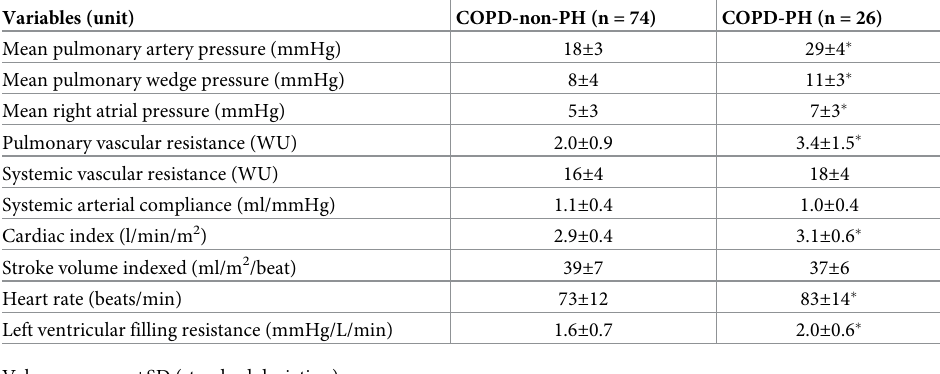
Table 2. Right heart catheterization values in patients with chronic obstructive pulmonary disease without (COPD-non-PH) and with pulmonary hypertension (COPD-PH). Variables (unit) COPD-non-PH (n = 74) COPD-PH (n = 26) Mean pulmonary artery pressure (mmHg) 18 ± 3 29 ± 4 � Mean pulmonary wedge pressure (mmHg) 8 ± 4 11 ± 3 � Mean right atrial pressure (mmHg) 5 ± 3 7 ± 3 � Pulmonary vascular resistance (WU) 2.0 ± 0.9 3.4 ± 1.5 � Systemic vascular resistance (WU) 16 ± 4 18 ± 4 Systemic arterial compliance (ml/mmHg) 1.1 ± 0.4 Cardiac index (l/min/m 2 ) 3.1 ± 0.6 � Stroke volume indexed (ml/m 2 /beat) 39 ± 7 37 ± 6 Heart rate (beats/min) 73 ± 12 Left ventricular filling resistance (mmHg/L/min) 1.6 ± 0.7 2.0 ± 0.6 � Values are mean ± SD (standard deviation). � Significantly different from